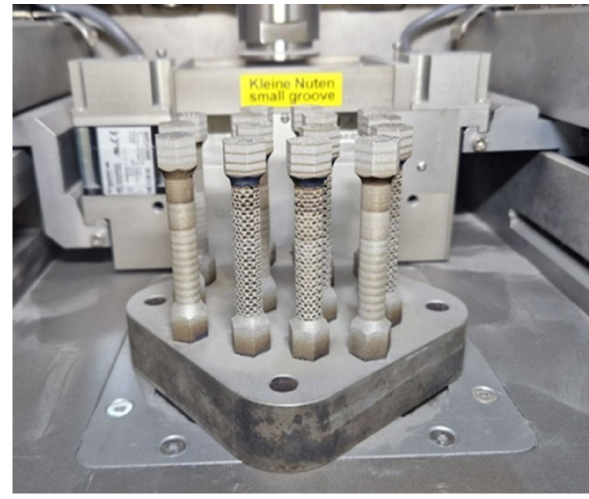
Figure 6. Samples after cleaning from unmelted powder.